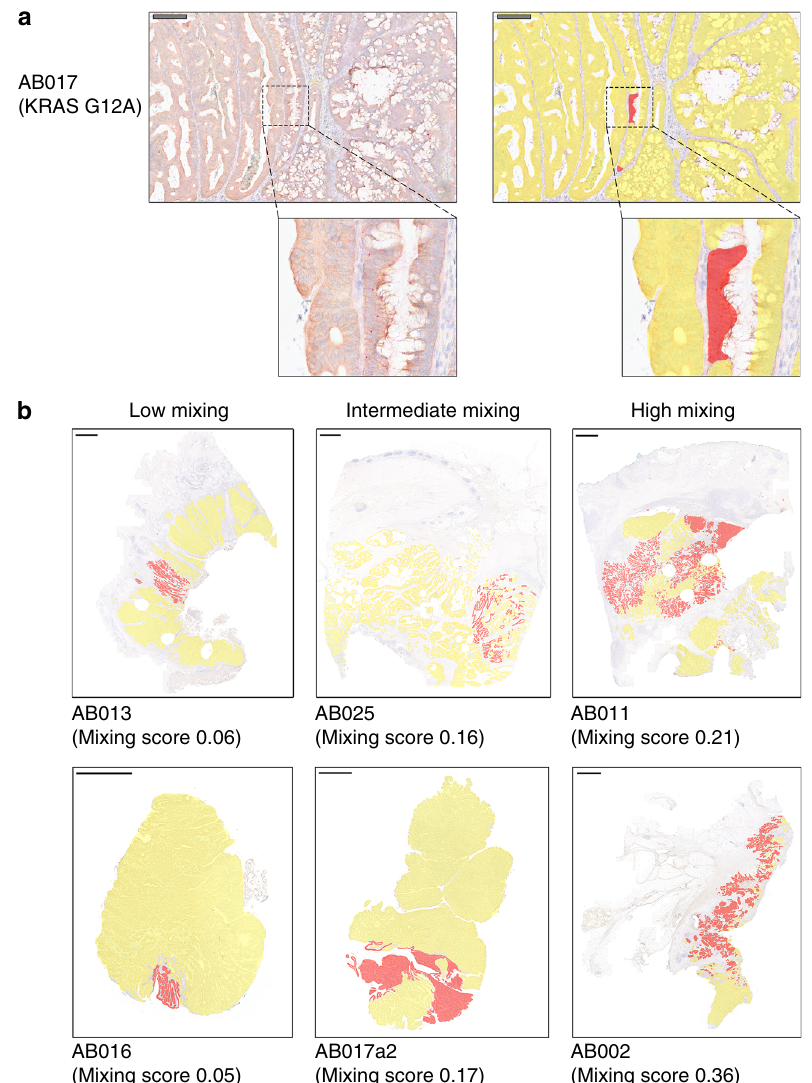
Fig. 3 BaseScope detection of CRC subclonal architecture. a Representative images showing BaseScope detection of a small patch of mutant cells (red) within a fi eld of wild-type cells (yellow). Scale bars represent 200 micron. b Representative topographical maps of subclonal architecture showing the spatial arrangement of mutant (red) and wild-type (yellow) subclones. Examples of low mixing (left column), intermediate mixing (middle column) and high mixing (right column) are shown. Scale bars represent 2000